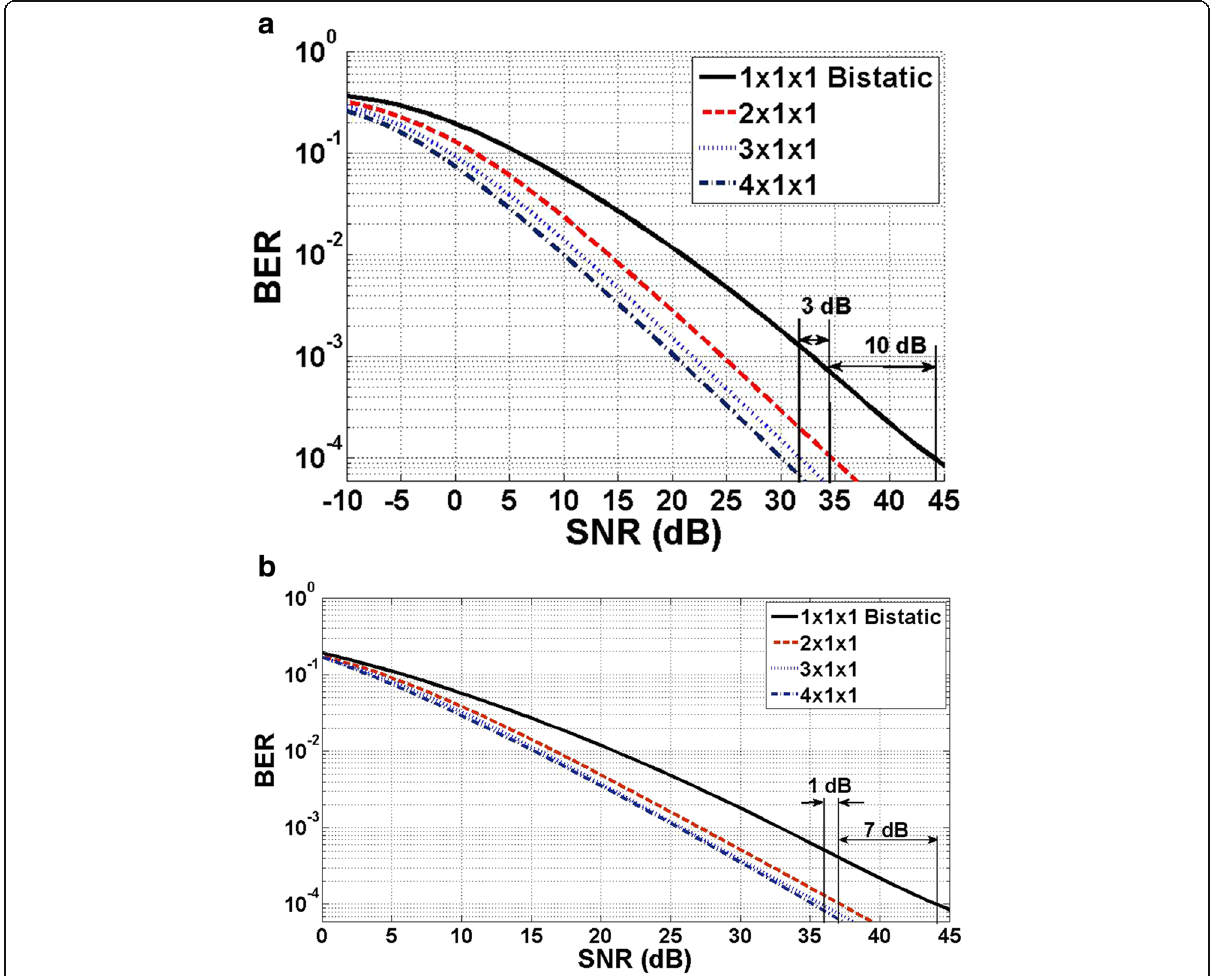
Fig. 5 Average BER curves for cascaded backscatter channels with independent, Rayleigh fading in forward and backscatter links. Un-coded BPSK modulation with coherent detection in the presence of AWGN noise is applied. Each curve represents the average BER of the signal at the n -th receiver with and without diversity. a Normalized total transmitted power with M transmitters (diversity gain and antenna array gain are represented). b Normalized BER to constant EIRP (diversity gain due to the altered channel statistics is